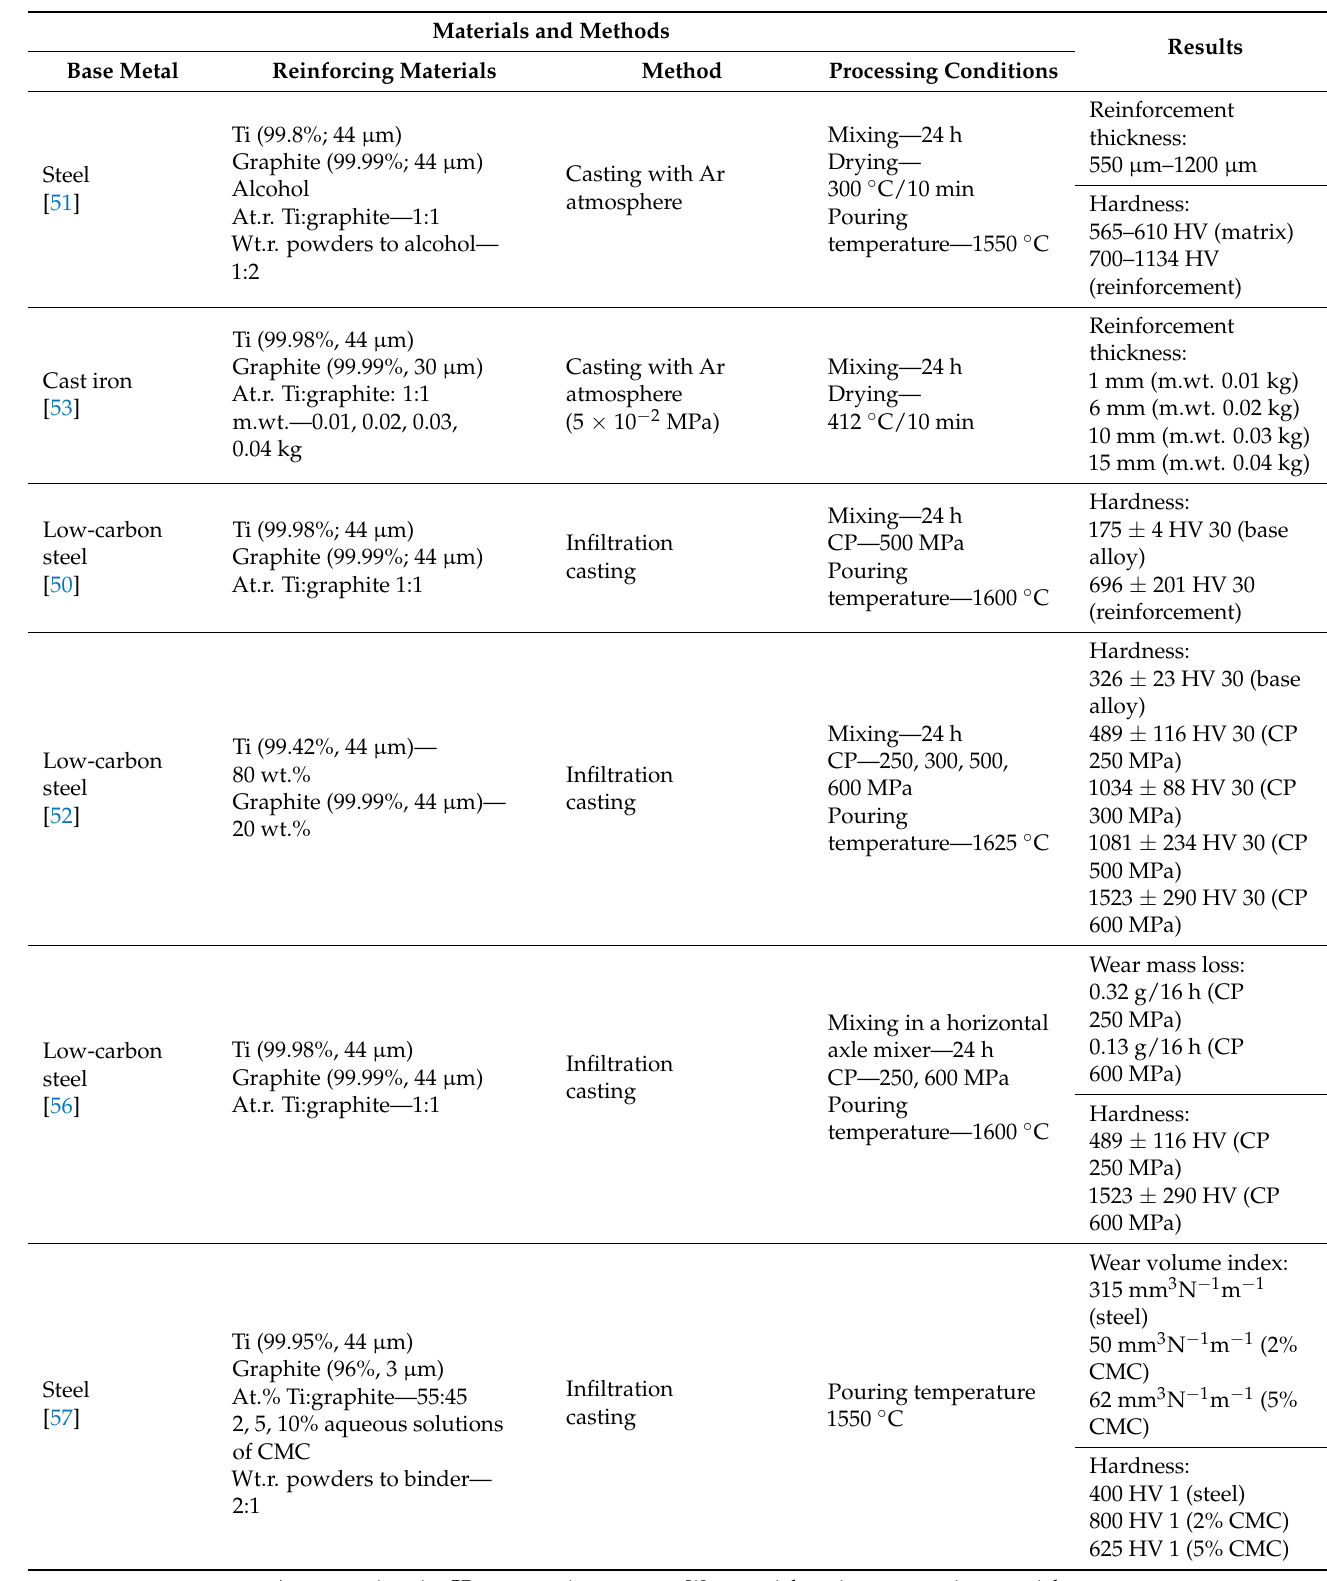
Table 2. Summary of experimental conditions and main results of SHS/casting processing using Ti-C powder